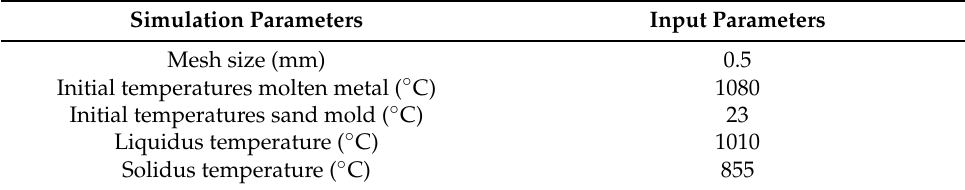
Table 6. Casting simulation input data of Cu–Sn alloy.